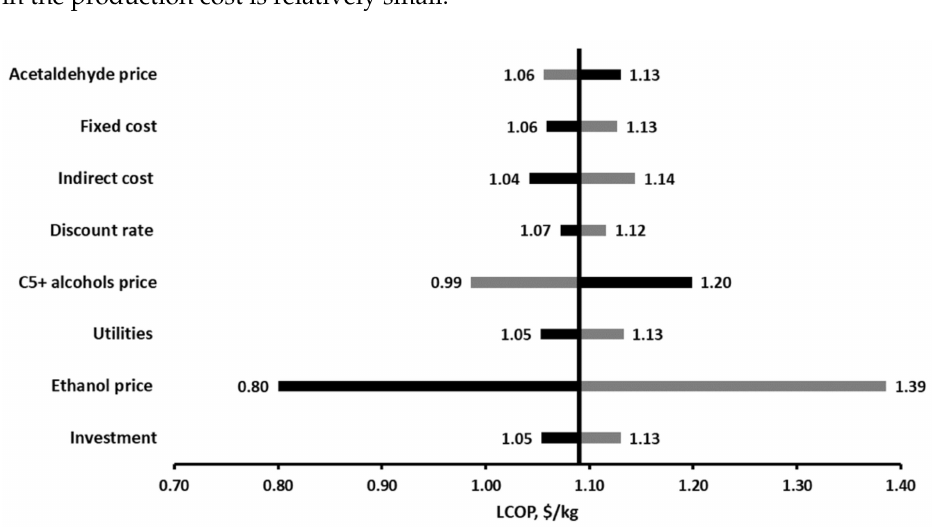
Figure 14. Sensitivity LCOP for selected technical and economic parameters.